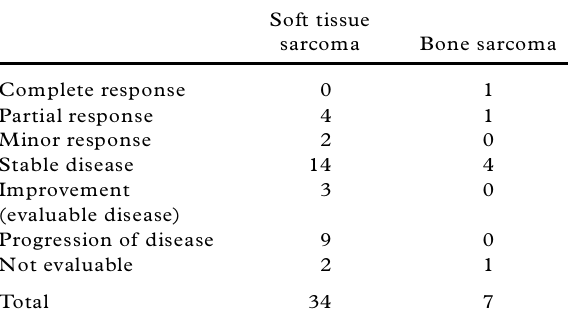
Table 6. Therapeutic response in 41 patients with